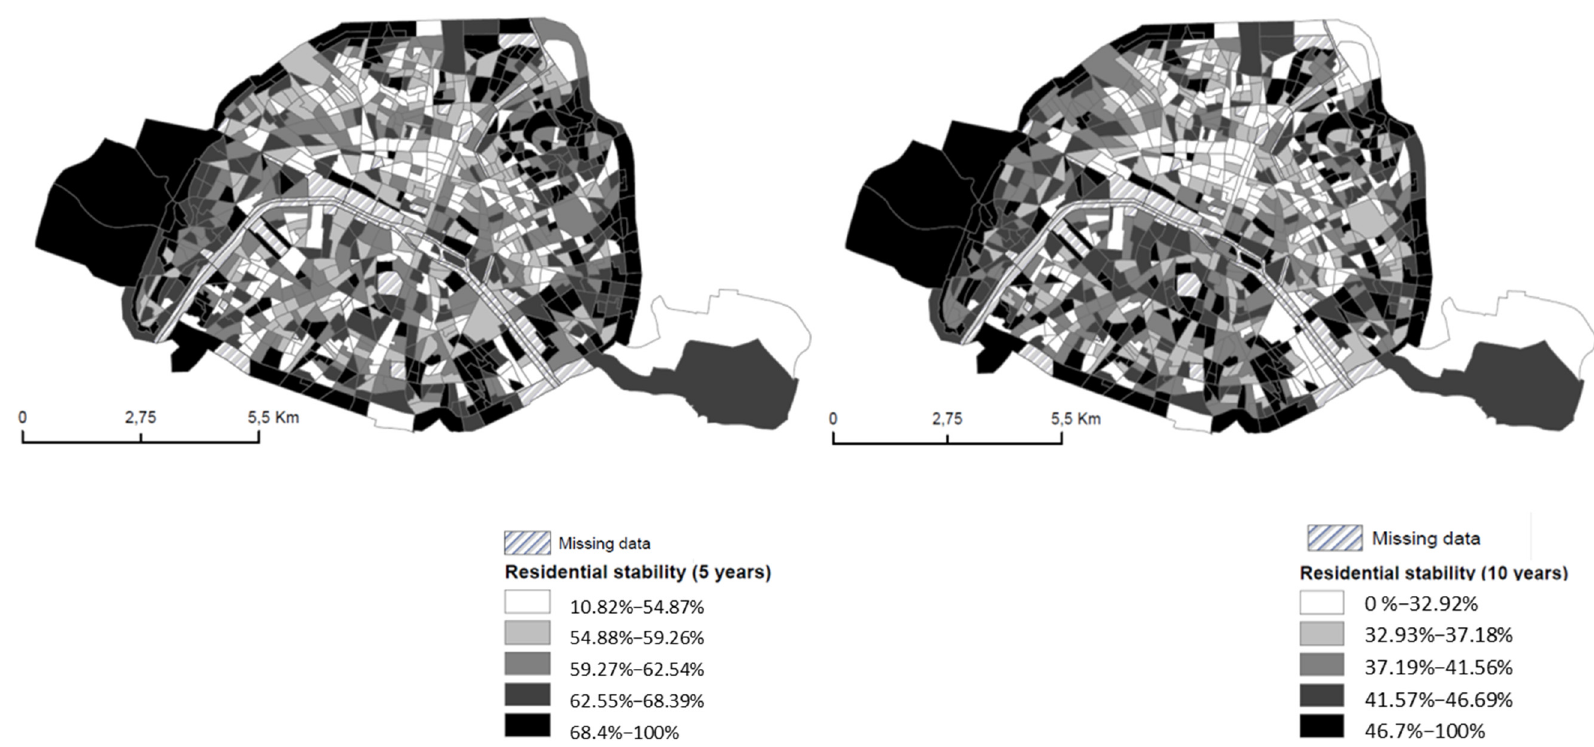
Figure 7. Spatial distribution of the proportion of people residing in 2006 in census block and living in the same census block 5 and 10 year before .